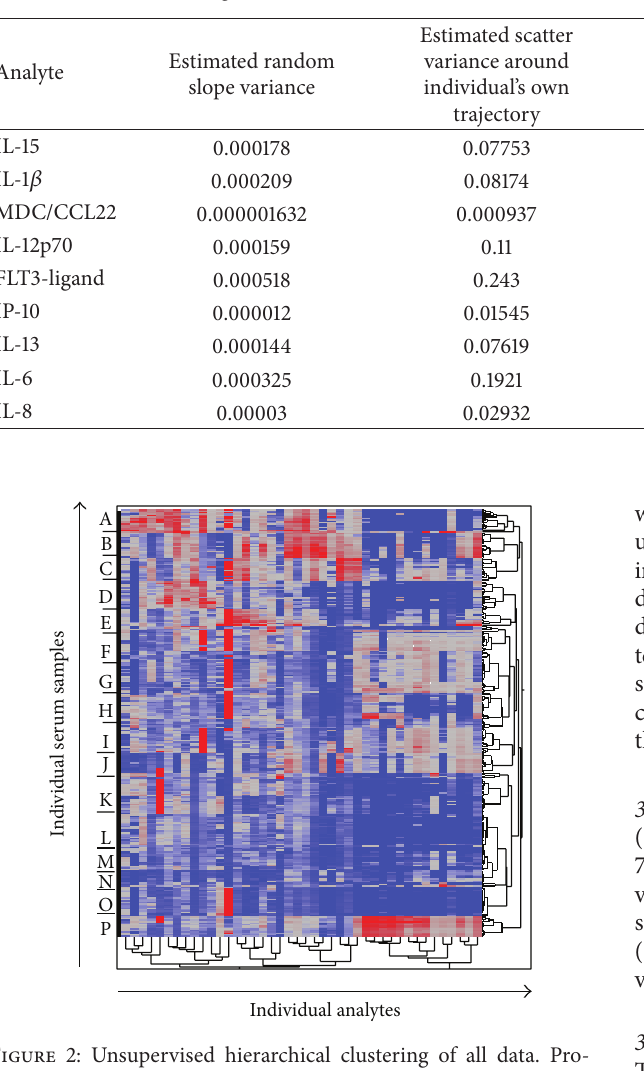
Table 2: Cytokines with gestational week (GW) as the time covariate, ordered by decreasing within-subject variance explained by adding GW to the unconditional growth model (UGM).